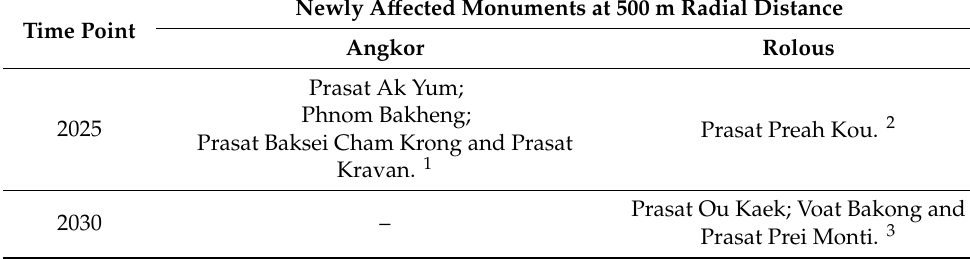
Table 4. List of monuments predicted to be affected.